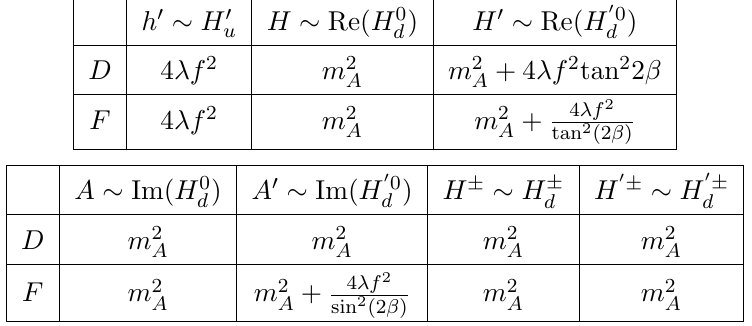
Table 1 . The mass spectrum of non-SM like Higgs bosons in the F -term and D -term Twin Higgs models in the U(4) symmetric and f (cid:29) v